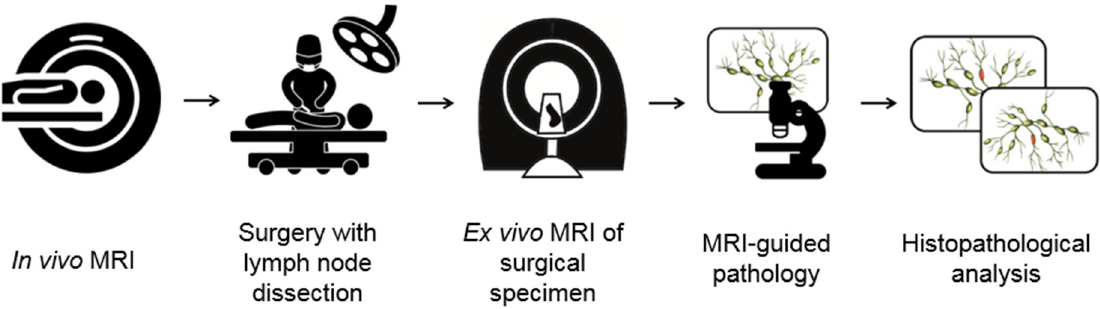
Figure 1. Schematic overview of the